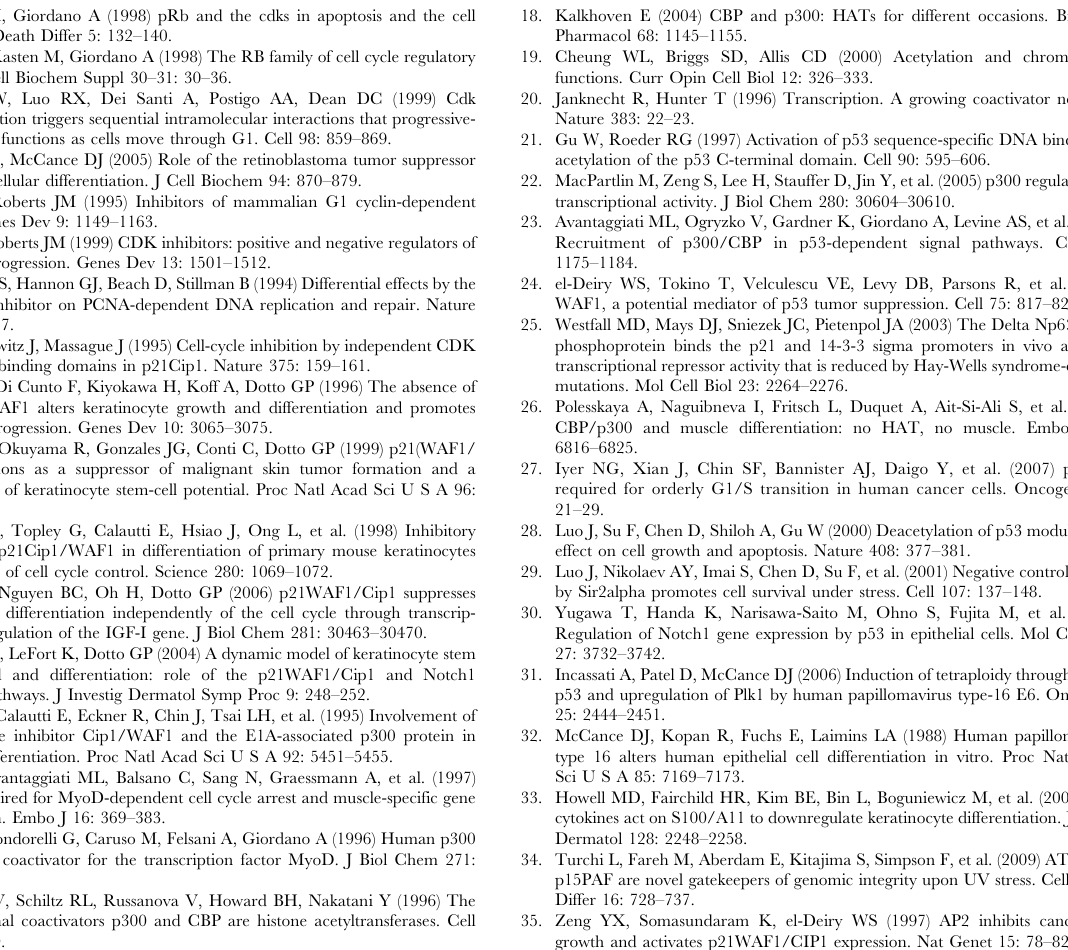
SE, three independent biological replicated; asterisk (*) p , 0.05 relative to relevant control, Student’s t test). Figure S4 Over-expression of p21 Waf1/CIP1 rescues the increase in proliferation in p300 depleted cells. Stably expressing p300 targeted shRNA cells were transiently transfected with either 1 m g pMT5-p21 Waf1/CIP1 -Flag vector or pCMV empty vector (negative control) for 24 hours. Transfected cells were then incubated with calcium for 48 hours. BrDU incorporation in control and p21 Waf1/CIP1 transfected cells was assessed after 48 hours transfection. Expression of p21 Waf1/CIP1 reduced the number of proliferating